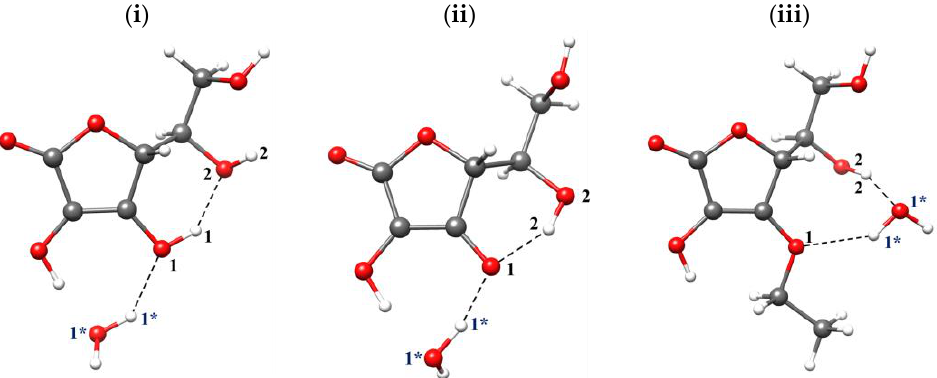
Figure 10. Optimized structures of microsolvation models of ascorbic acid in protonated ( i ), depro- tonated ( ii ) and ethylated ( iii ) form. Carbon, oxygen and hydrogen atoms are shown in grey, red and white, respectively.